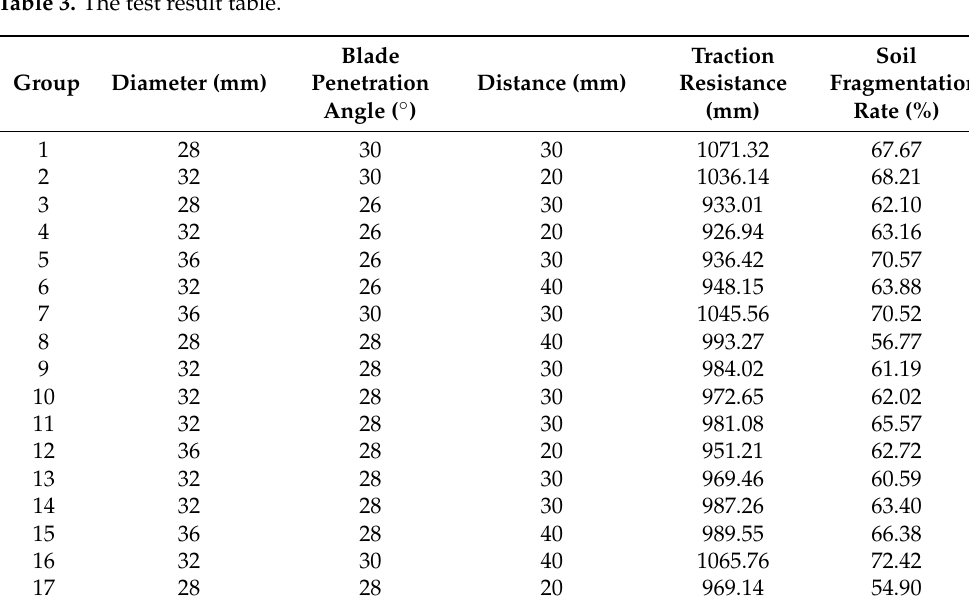
Table 3. The test result table.